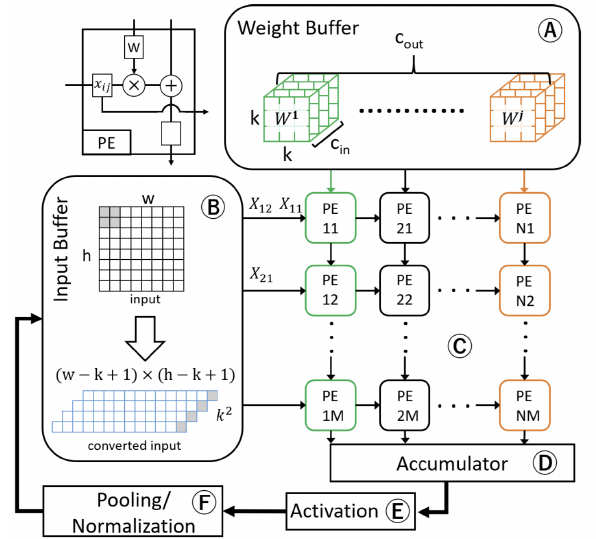
Figure 8. Overview of neural processing array core modules in weight-stationary dataflow. (Reprinted from ref.